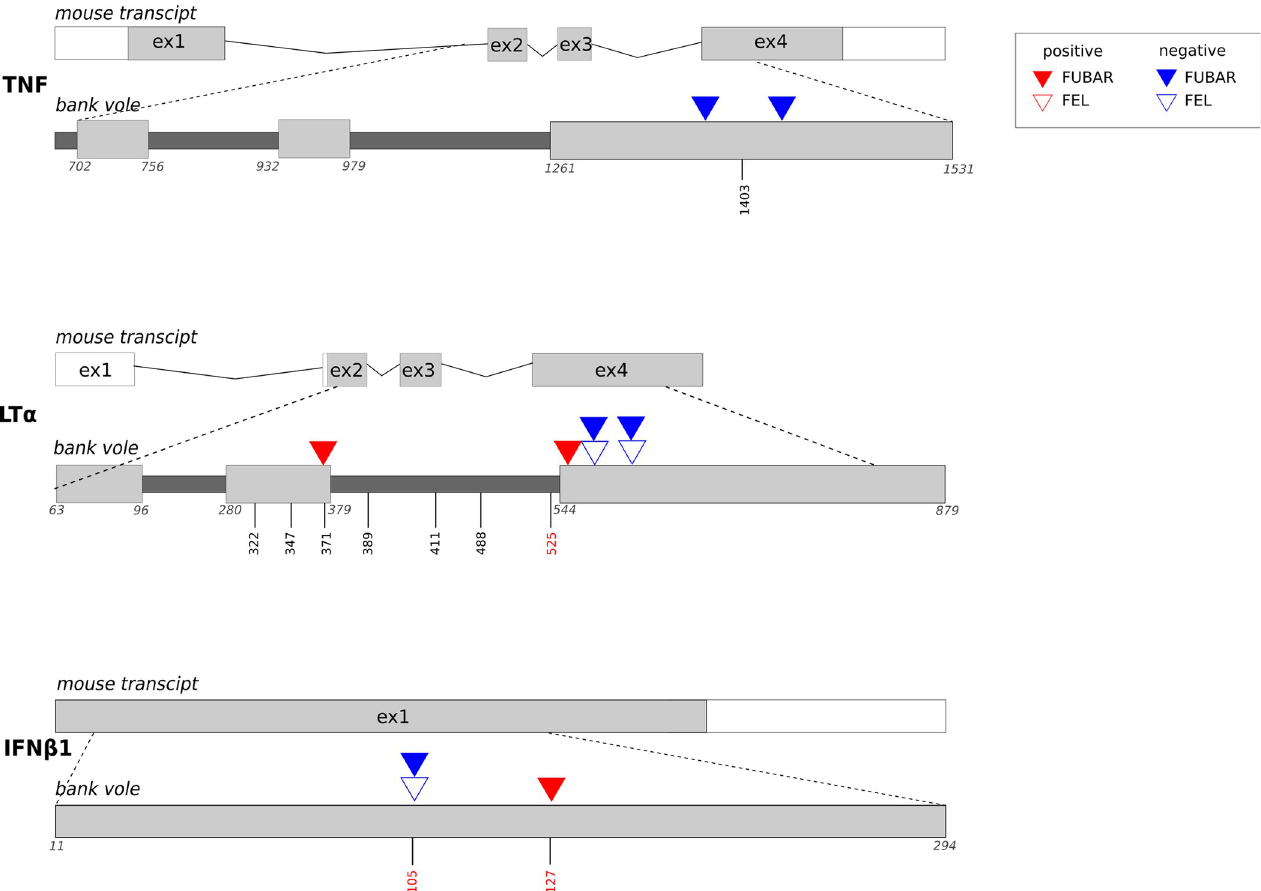
Fig 2. Schematic position of the sites under selection (marked as triangles) in the studied genes in relation to exon-intron structure. Positions of SNPs included in the GLM models are marked with bars and numbers, and in red we marked positions of SNPs that were significantly associated with parasite load. In bank vole sequences the numbers show distance in base pairs from the first transcribed nucleotide in mouse CDS. Note that the length of introns differed between mouse and vole.